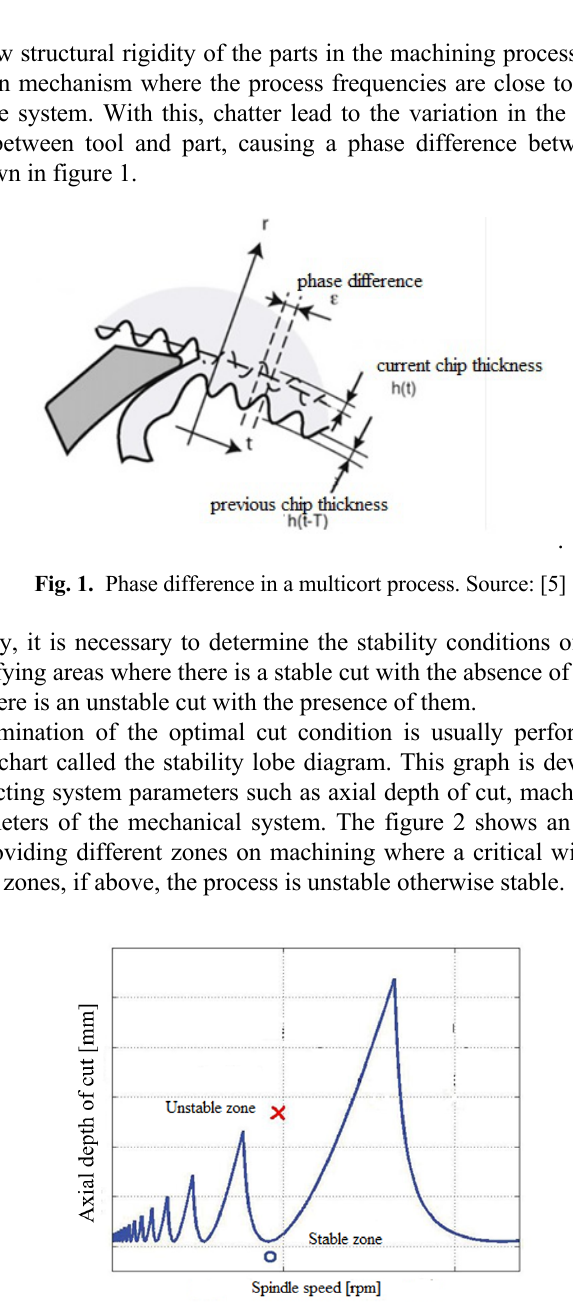
Fig. 2. Stability lobe